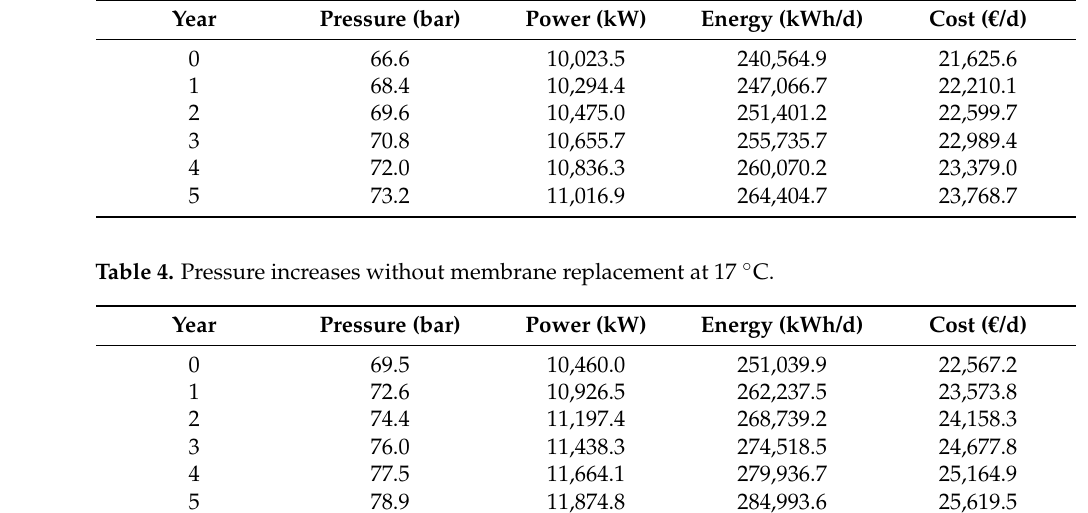
Table 3. Pressure increases without membrane replacement at 22 ◦ C.